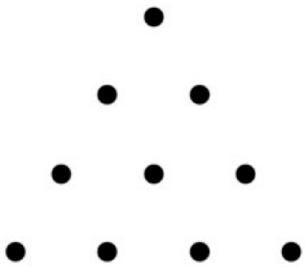
Figure 2. The Pythagorean tetraktys